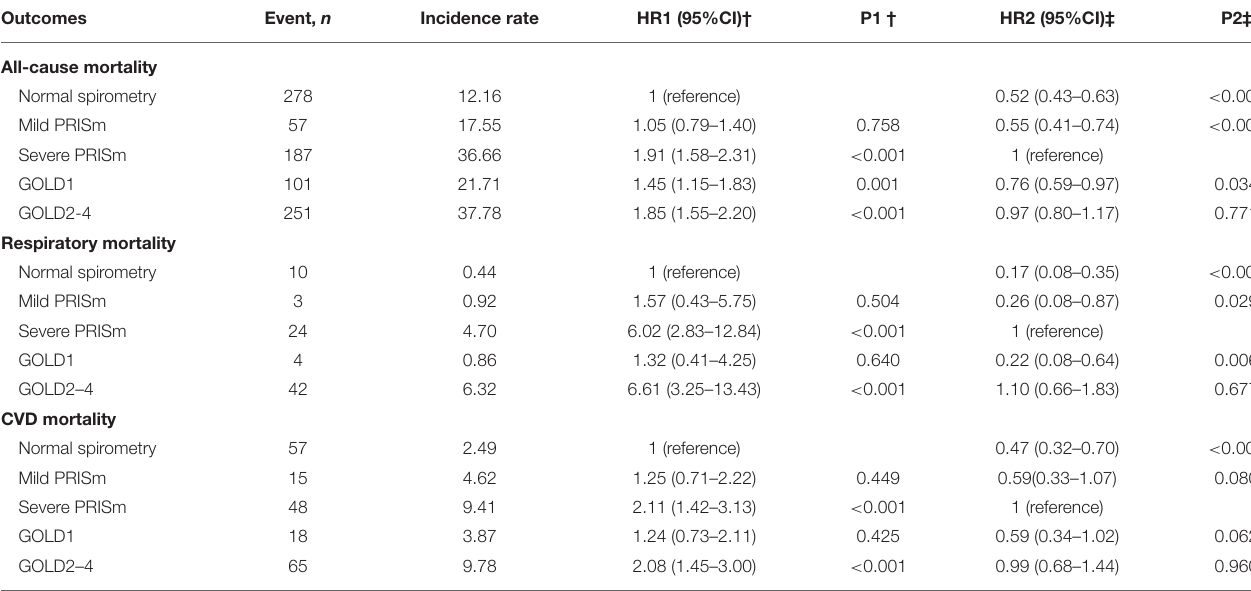
TABLE 2 | Incidence rates and risks of all-cause mortality, respiratory mortality, and CVD mortality among different lung function categories.